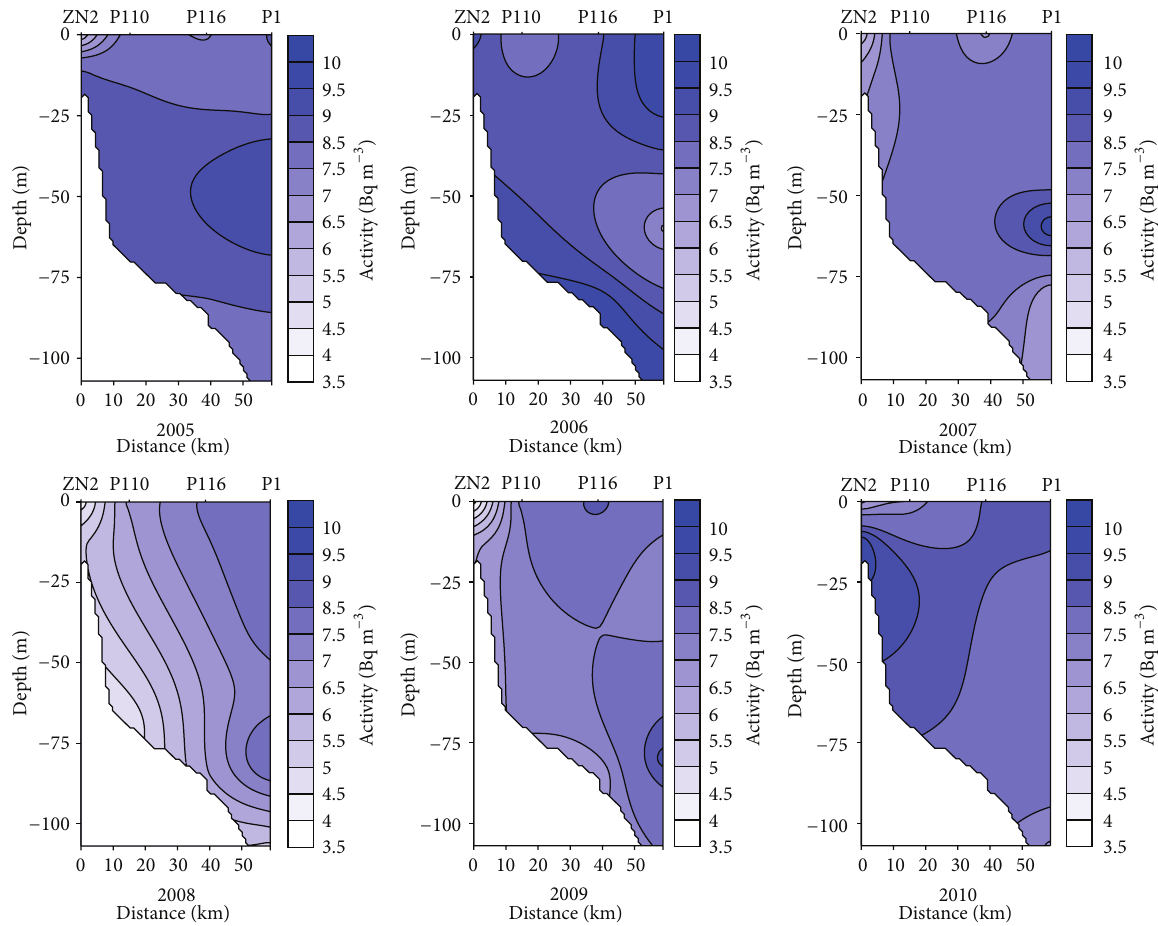
Figure 5: Seasonal and spatial variations in 90 Sr activity in the estuarine profile in the years of